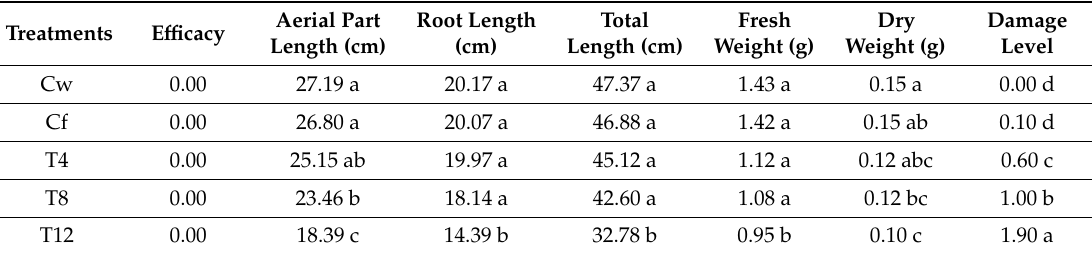
Table 10. E ffi cacy, e ff ects on several plant traits (aerial part, root and total length, fresh and dry weight), and damage level of TC4 EO at di ff erent application doses on E. crus-galli . T4, T8, T12: 4, 8, 12 µ L / mL EO; Cw: water control; Cf: Fitoil control.